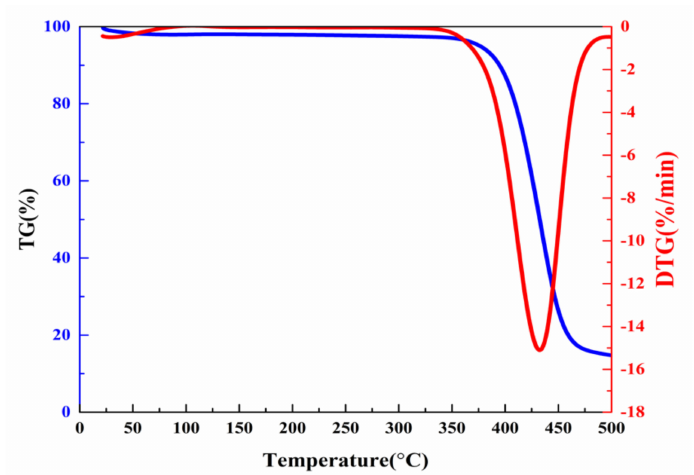
Figure A7. Illustration of indoor test.